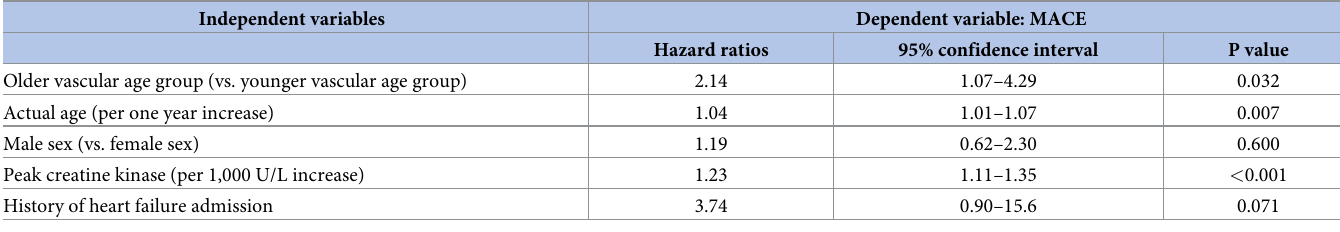
Table 4. Multivariate Cox hazards analysis to predict